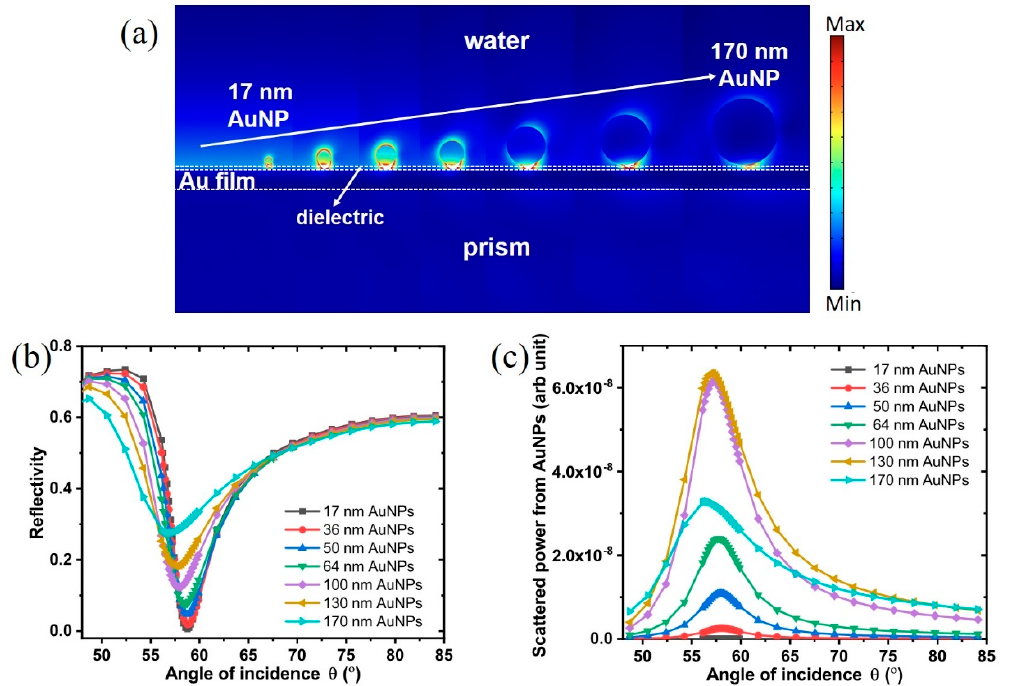
Figure 1. ( a ) Simulation of the field enhancement distribution on the SPR sensor surface for AuNPs with diameters ranging from 17 to 170 nm. Simulated angular SPR spectra ( b ) and scattered power ( c ) as a function of the incident angle AuNP probes with diameters ranging from 17 to 170 nm. Configuration for simulation: dielectric layer thickness of 10 nm; pitch between AuNPs at p = 800 nm.